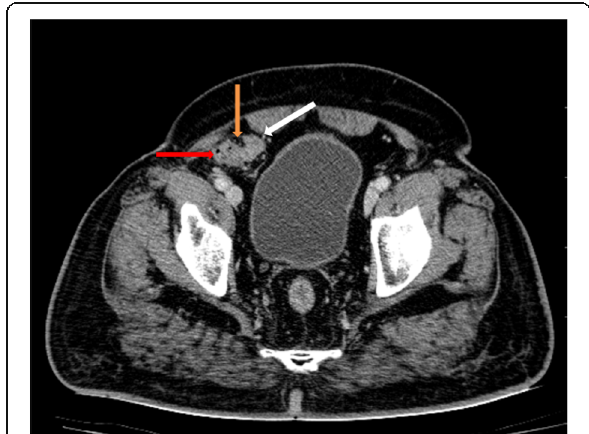
Fig. 2 CT abdomen axial section venous phase at the level of the pelvis shows presence of cecum (red arrow), ileocecal junction (yellow arrow), and terminal ileum (white arrow) are within the hernial